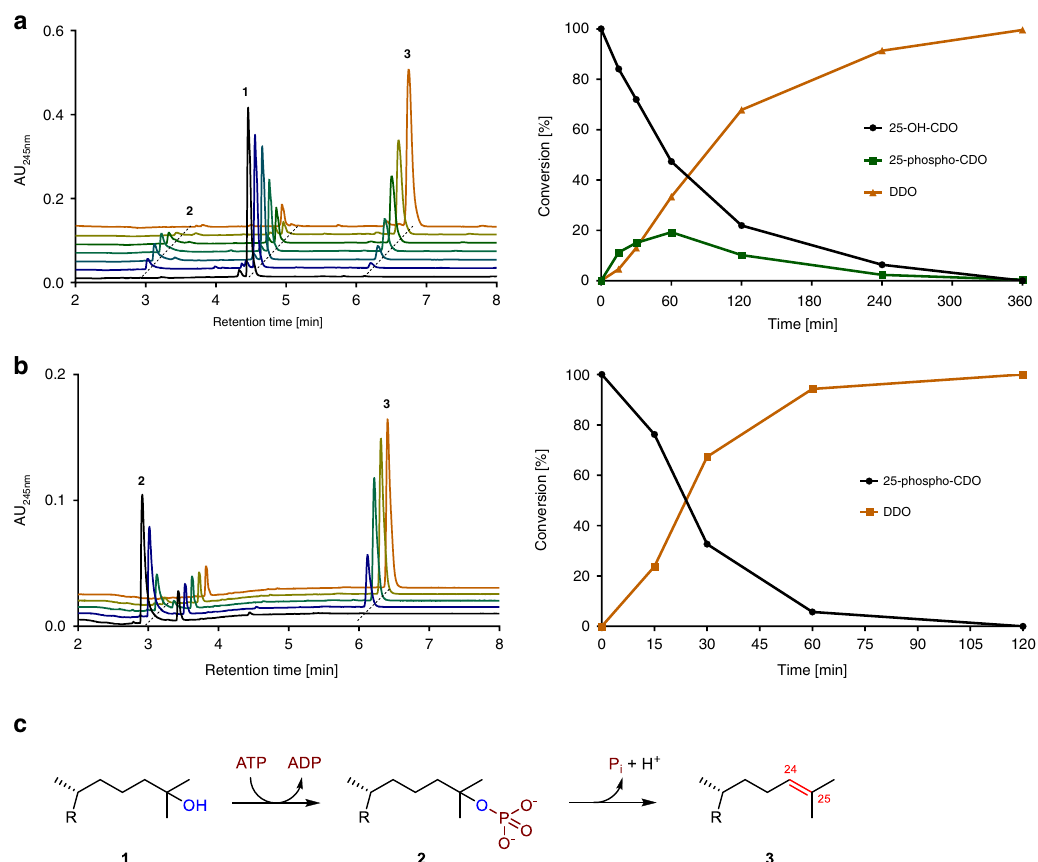
Fig. 2 Oxygen-independent conversion of 25-OH-cholesta-1,4-dien-3-one (1). a Time-, ATP-, and MgCl 2 -dependent conversion of 0.5 mM 25-OH-CDO in soluble cell extracts of S. denitri fi cans . b ATP-independent conversion of chemically synthesised 25-phospho-CDO. c Proposed reaction sequence of ATP-dependent dehydration of 25-OH-CDO 1 via 25-phospho-CDO 2 to desmost-1,4-diene-3-one (DDO, 3 ). Source data are provided as a Source Data fi